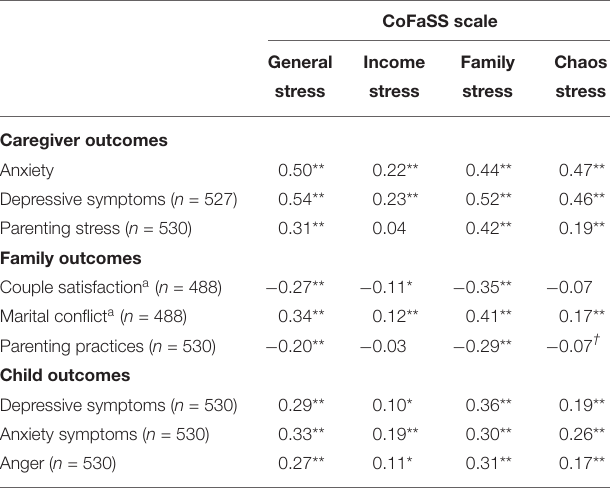
TABLE 4 | Spearman rho correlations between the CoFaSS scales and caregiver, family, and child